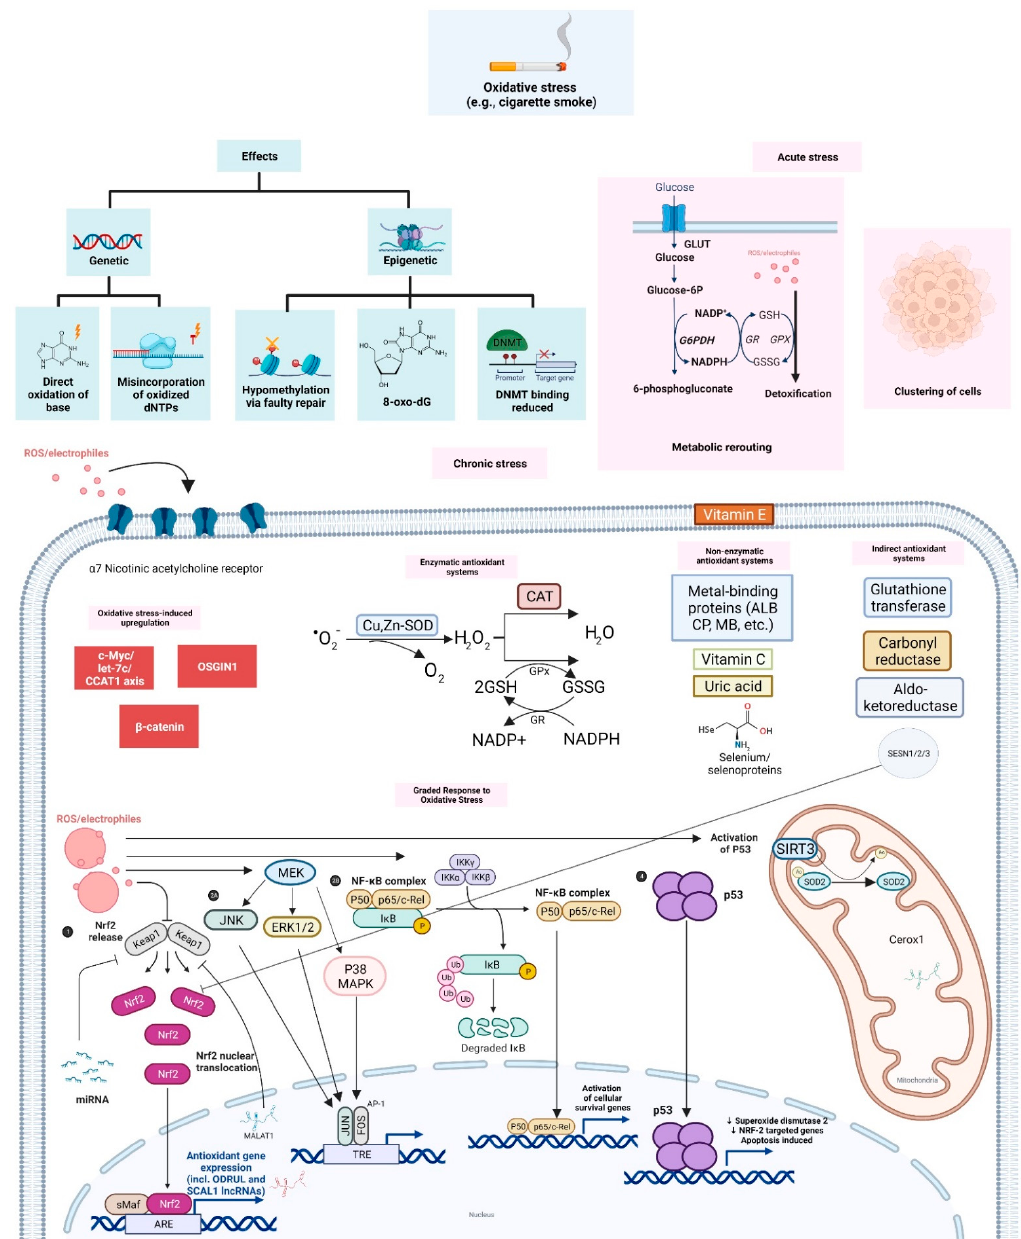
Figure 1. Schematic view of the cellular effects and responses of cells to sources of oxidative stress (including cigarette smoke exposure). Cigarette smoke exposure causes several genetic and epige ‐ netic alterations. Depending on the length and/or intensity of stress exposure, cells utilize various survival and adaptive mechanisms. Under acute stress, cells undergo metabolic rerouting, resulting